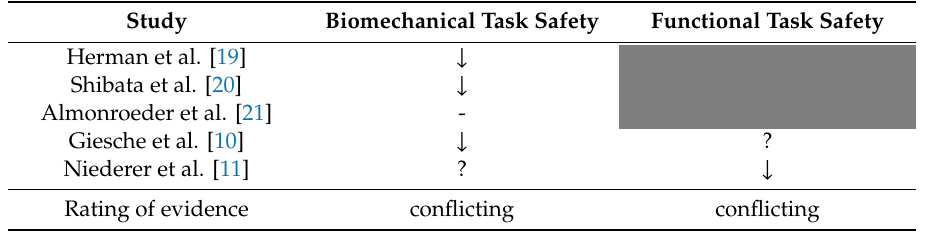
Table 4. Synthesized results for the relationship between perceptual–cognitive function and unplanned task safety. Study